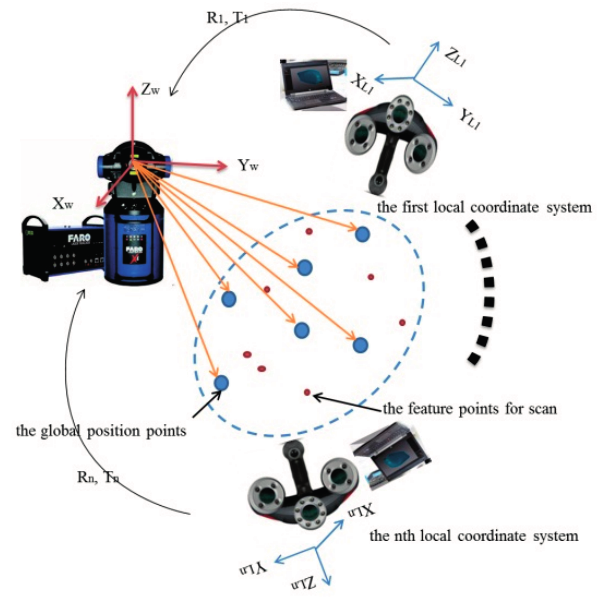
Figure 2. Schematic of the combined